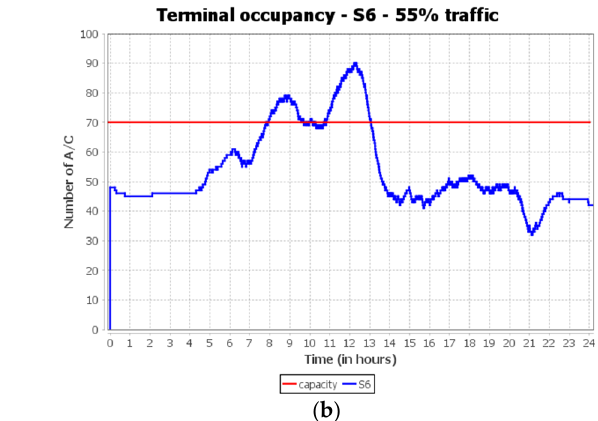
Figure 10. Taxiway ( a ) and terminal ( b ) occupancy scenario S4.